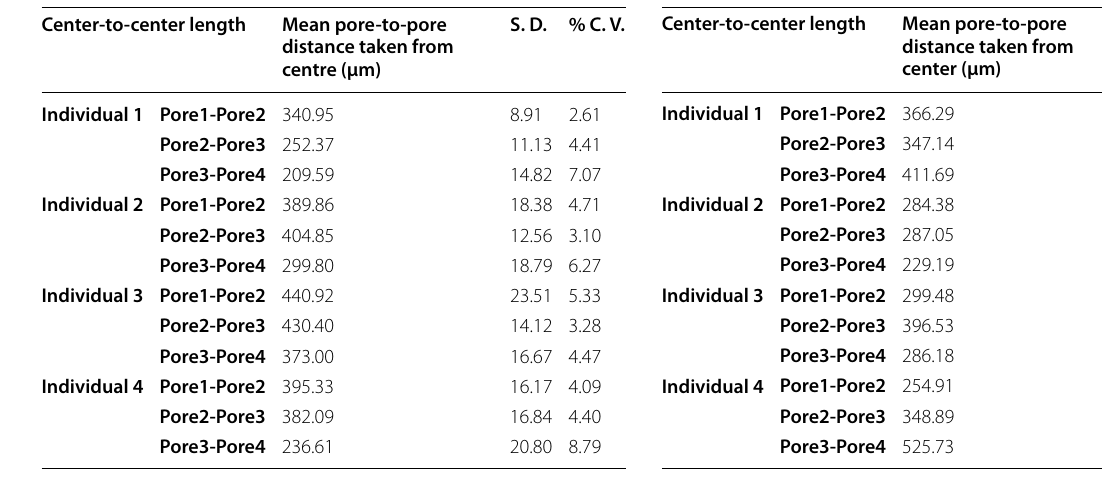
pore center-to-center distance, standard deviation (S. D.), and % coefficient of variation (% C.V.) of four pores, taken from fingerprints obtained from the right index finger of four individuals on sticky side of adhesive tape (using method described in (ii)), recorded on ten consecutive days, shows % C. V. to lie within and/or near the normal